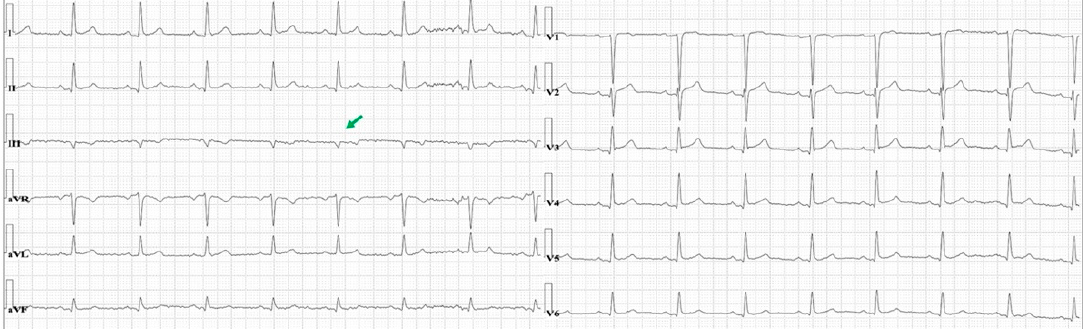
Figure 3. A 12-lead electrocardiogram recorded after chest tube placement. Isolated very low voltage is still seen in lead III (green arrow).